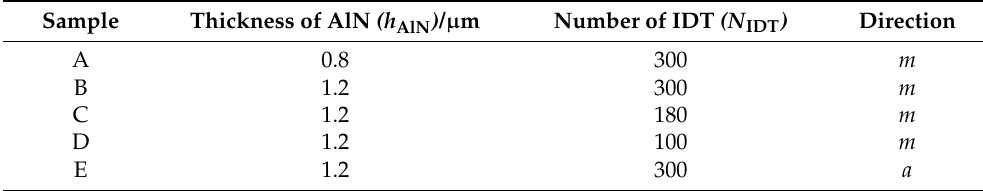
Table 1. Device parameters of fabricated AlN/sapphire-based SAW sensors.